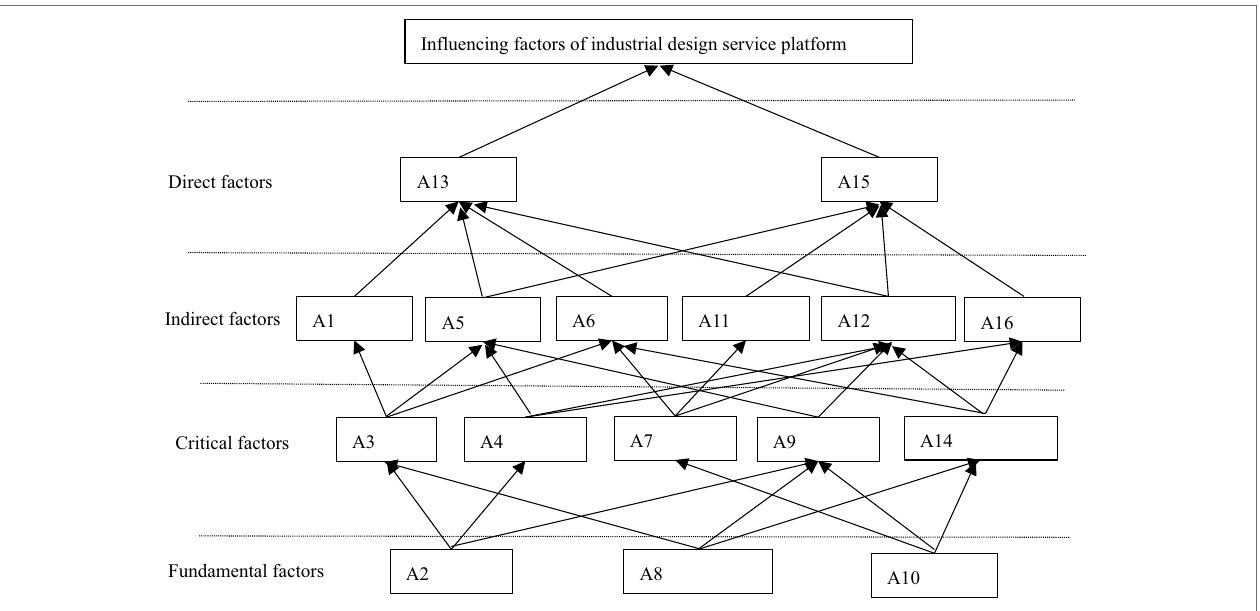
FIGURE 2 | ISM model of influencing factors of industrial design service